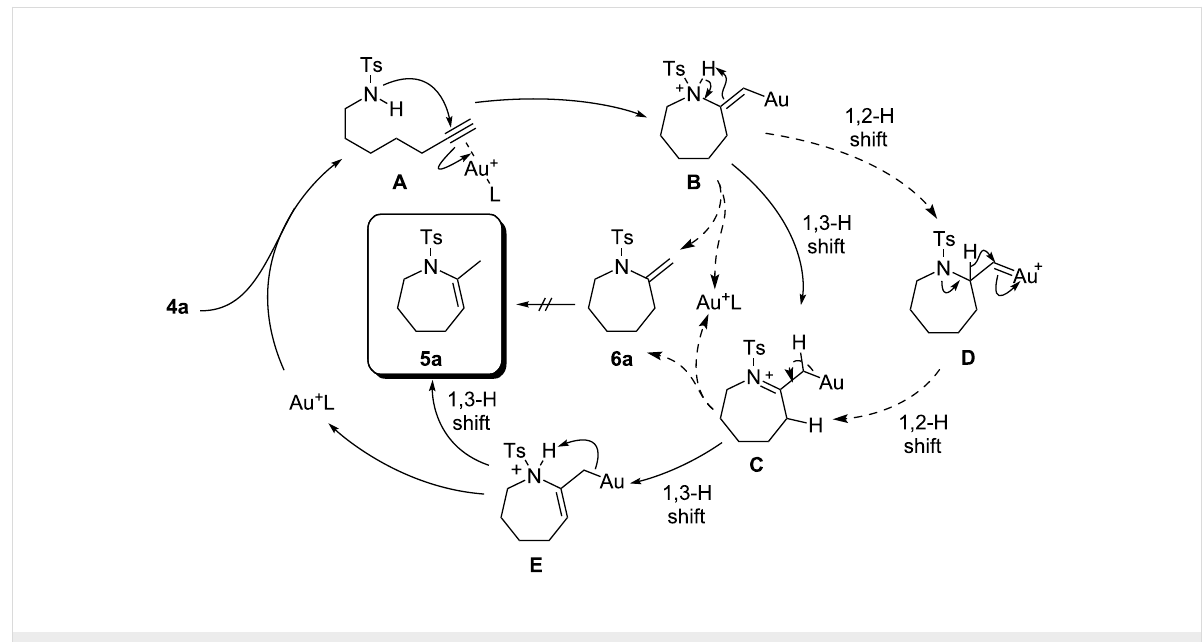
Figure 4: Possible pathway for the gold-catalyzed conversion of 4a into 5a .